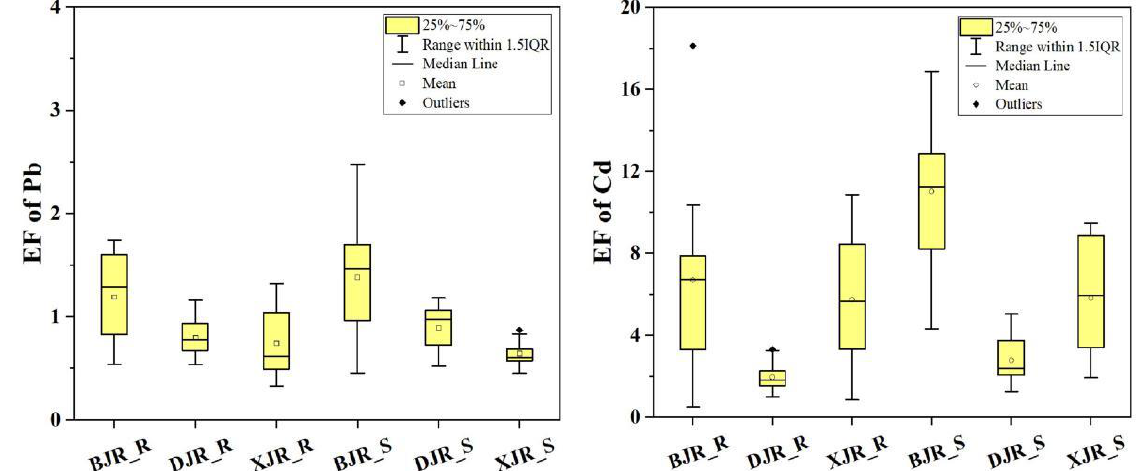
Figure 4. Enrichment factors of Pb and Cd in riparian soils and river sediments from three reaches.